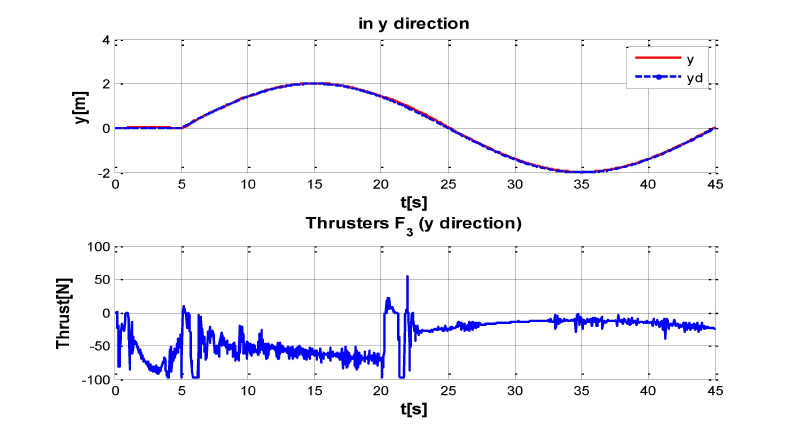
Figure 6. Behavior of the system in y-coordinate with perturbations up and (down) control signal of thruster F3.